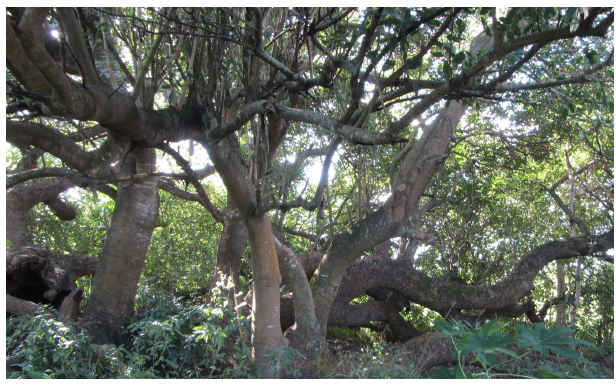
Fig. 5. The sacred